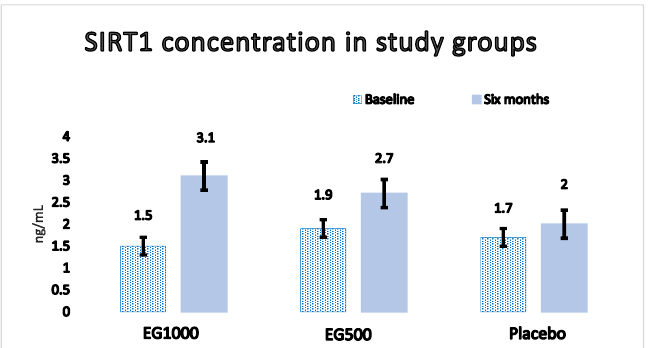
Figure 2. SIRT1 concentration in study groups: baseline and after six months. Data are presented as mean ± SE. A statistically significant increase (1.5 ± 0.15 vs. 3.1 ± 0.20 ng/mL; p < 0.05) in EG1000 is observed after follow-up.